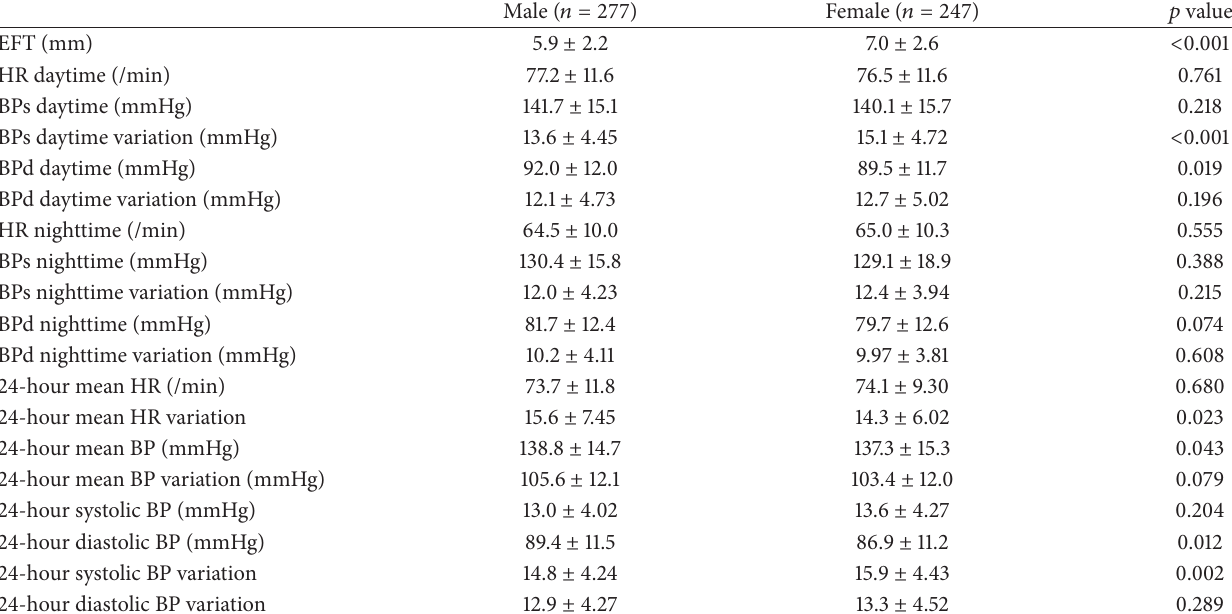
Table 5: Comparison of ambulatory blood pressure parameters between male and female